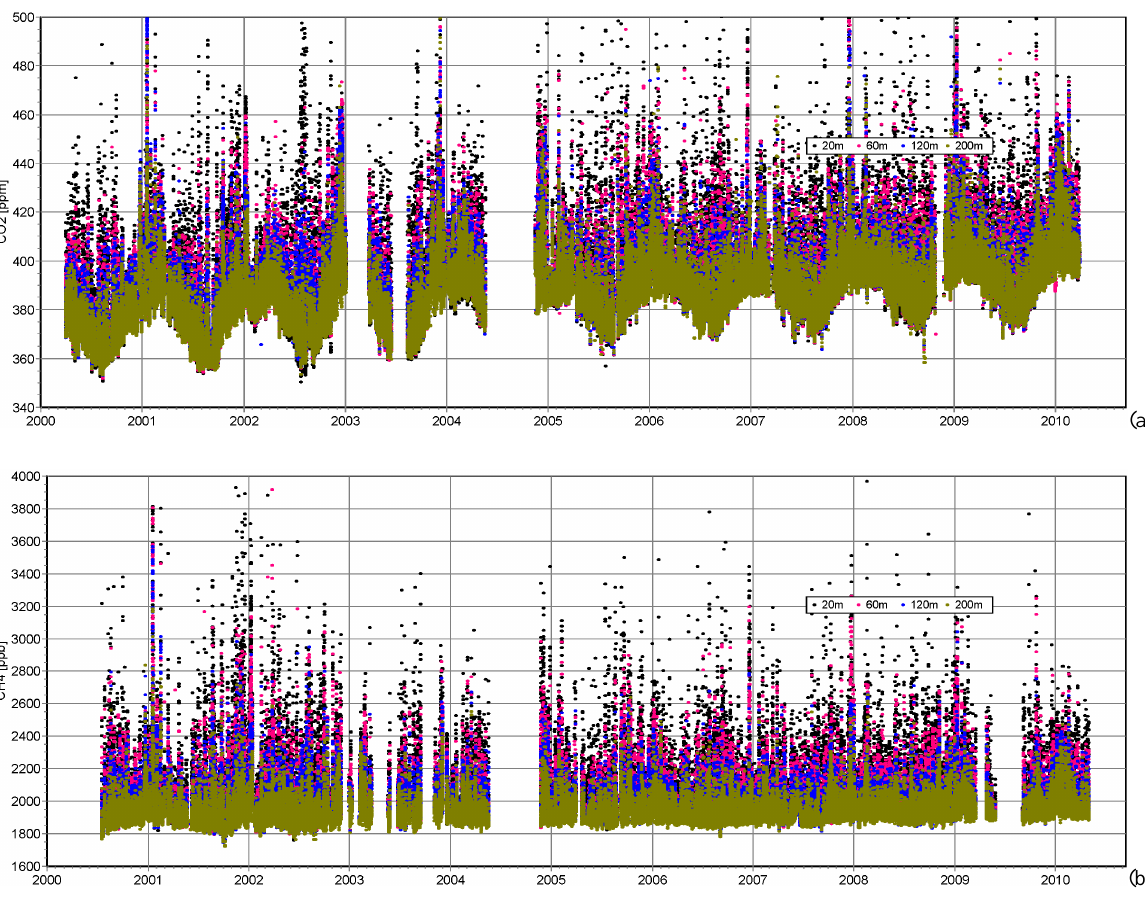
Fig. 10. Overview of the time series (2000–2010) of hourly concentration gradient of CO 2 (a) and CH 4 (b) at Cabauw for the vertical levels 200 (green), 120 (blue), 60 (pink) and 20 (black) m a.g.l. Table 4. Measurement results for CO 2 for the whole observation period. Numbers in grey refer to years with incomplete data because of instrumental failures or start or stop of the observations during that year. All concentrations in ppm.